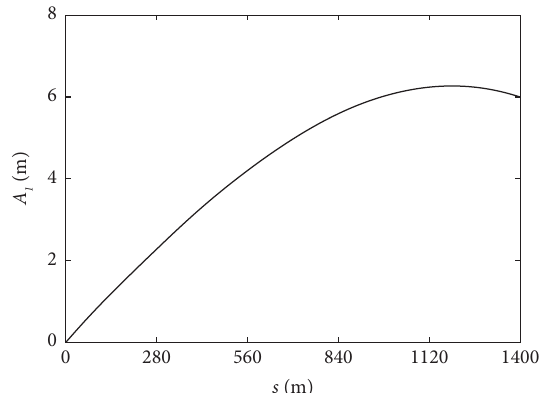
Figure 7: Dynamic confguration of mooring under tangential excitation.